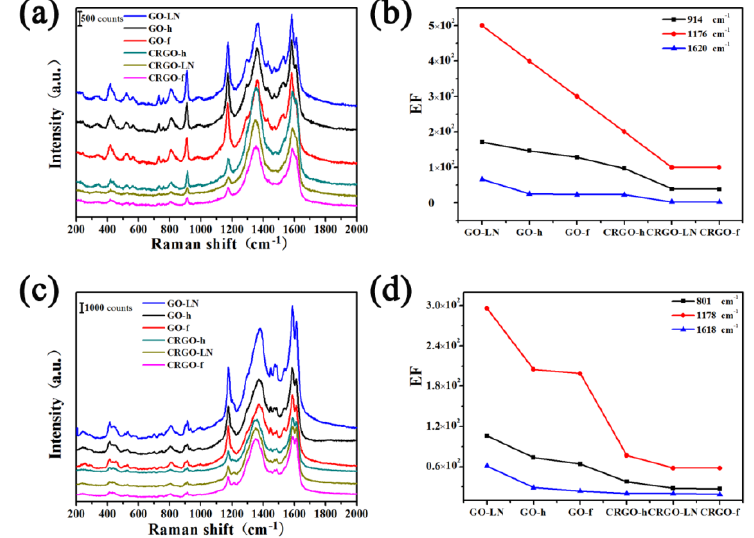
Figure 5. ( a ) Raman spectra and ( b ) enhancement factors (EFs) for the main vibration modes of CV deposited on different films by soaking in 1 × 10 −5 M CV solution; ( c ) Raman spectra and ( d ) EFs for the main vibration modes of MG deposited on different films by soaking in 1 × 10 −4 M MG solution.